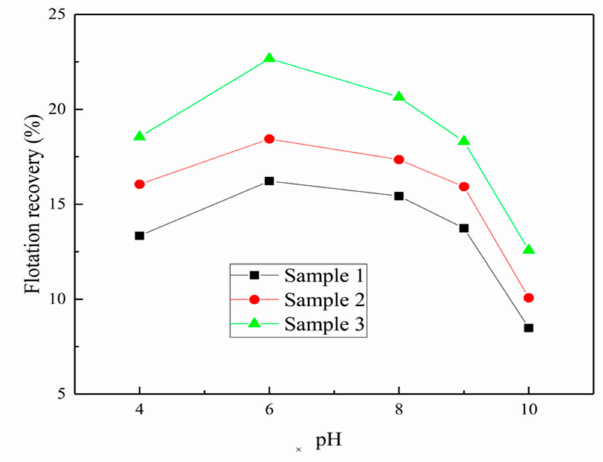
Figure 2. Flotation recovery of the three samples as a function of the pH.